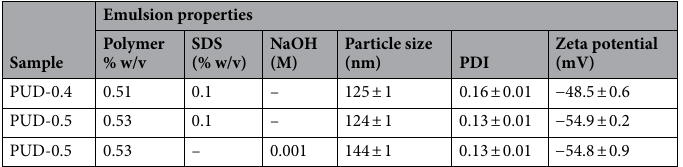
Table 4. Summary of particle size and Zeta potential of PLA-based PUD emulsions in the presence of SDS surfactant and alkaline environment.